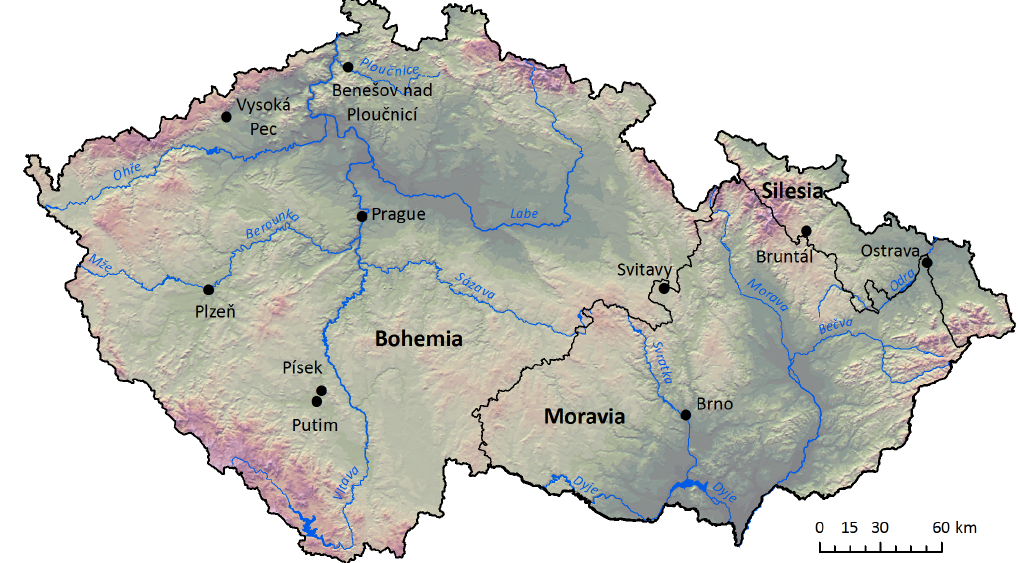
Figure A1. Locations in the Czech Republic mentioned in this paper (data source: ArcˇCR 500